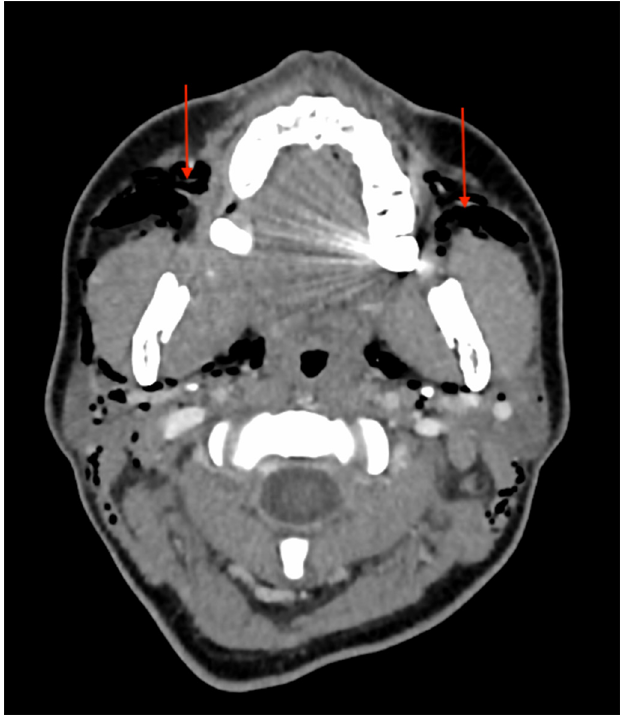
Fig. 2. Axial head and neck computed tomogram. Air accumulation in parapharyngeal, retropharyngeal and massage spaces.